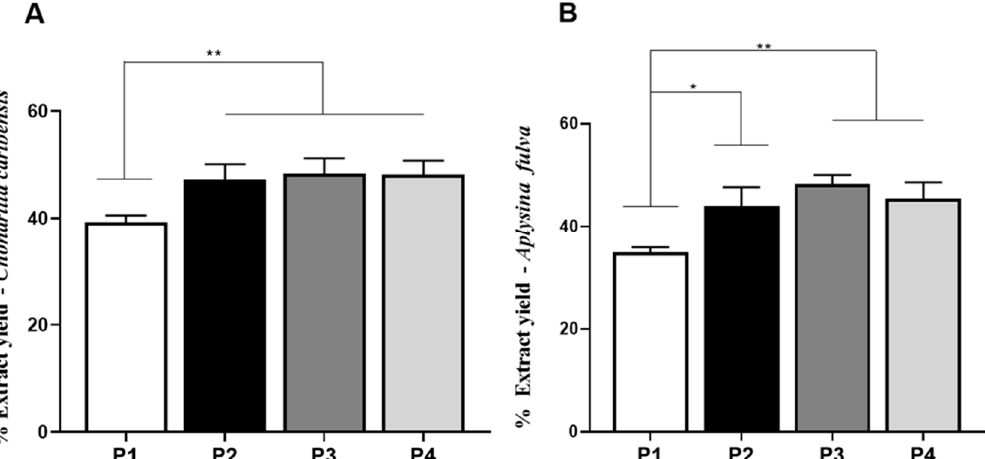
Figure 5. Extract yield evaluation. ( A ) Percentage of extract yield obtained from the specie C. caribensis using P1, P2, P3, and P4. Statistical differences were found between P1 vs. P2, P3 and P4 ** ( p < 0.01). ( B ) Percentage of extract for A. fulva species using P1, P2, P3 and P4. Statistical differences were verified between P1 vs. P2 * ( p = 0.0128) and P1 vs. P3 and P4 ** ( p < 0.01). There was no statistical difference between protocols P2, P3 and P4 ( p > 0.05). All analyzes were performed in triplicate (Anova/Tukey test).